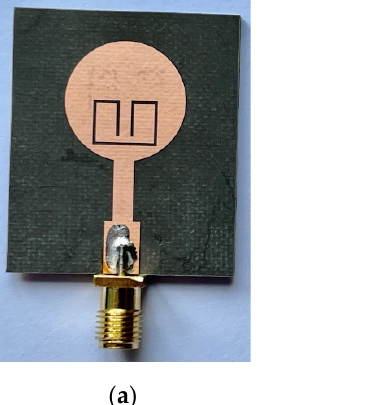
Figure 13. Photos of the antenna prototype. ( a ) The front of the antenna. ( b ) The back of the antenna.